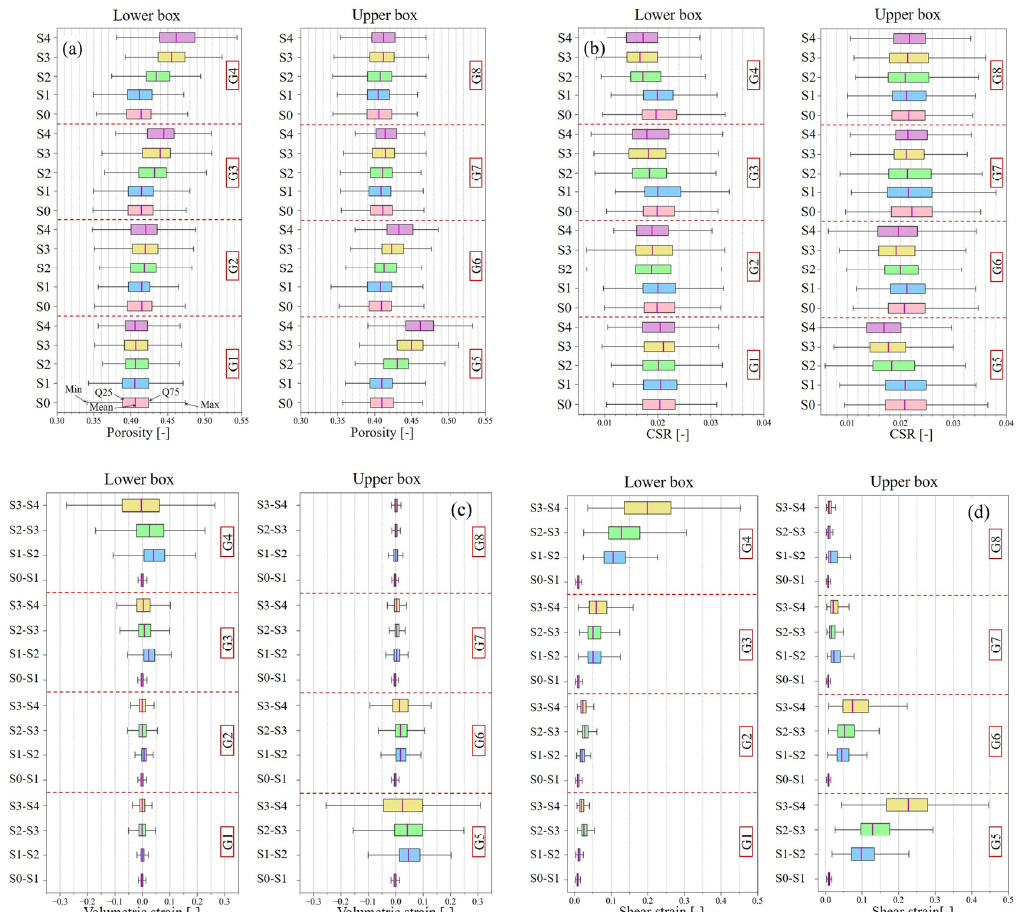
Figure 15. Statistical analysis (represented as box plots) for each group: ( a ) porosity, ( b ) ratio of contact surface between particles, ( c ) volumetric strain, and ( d ) shear